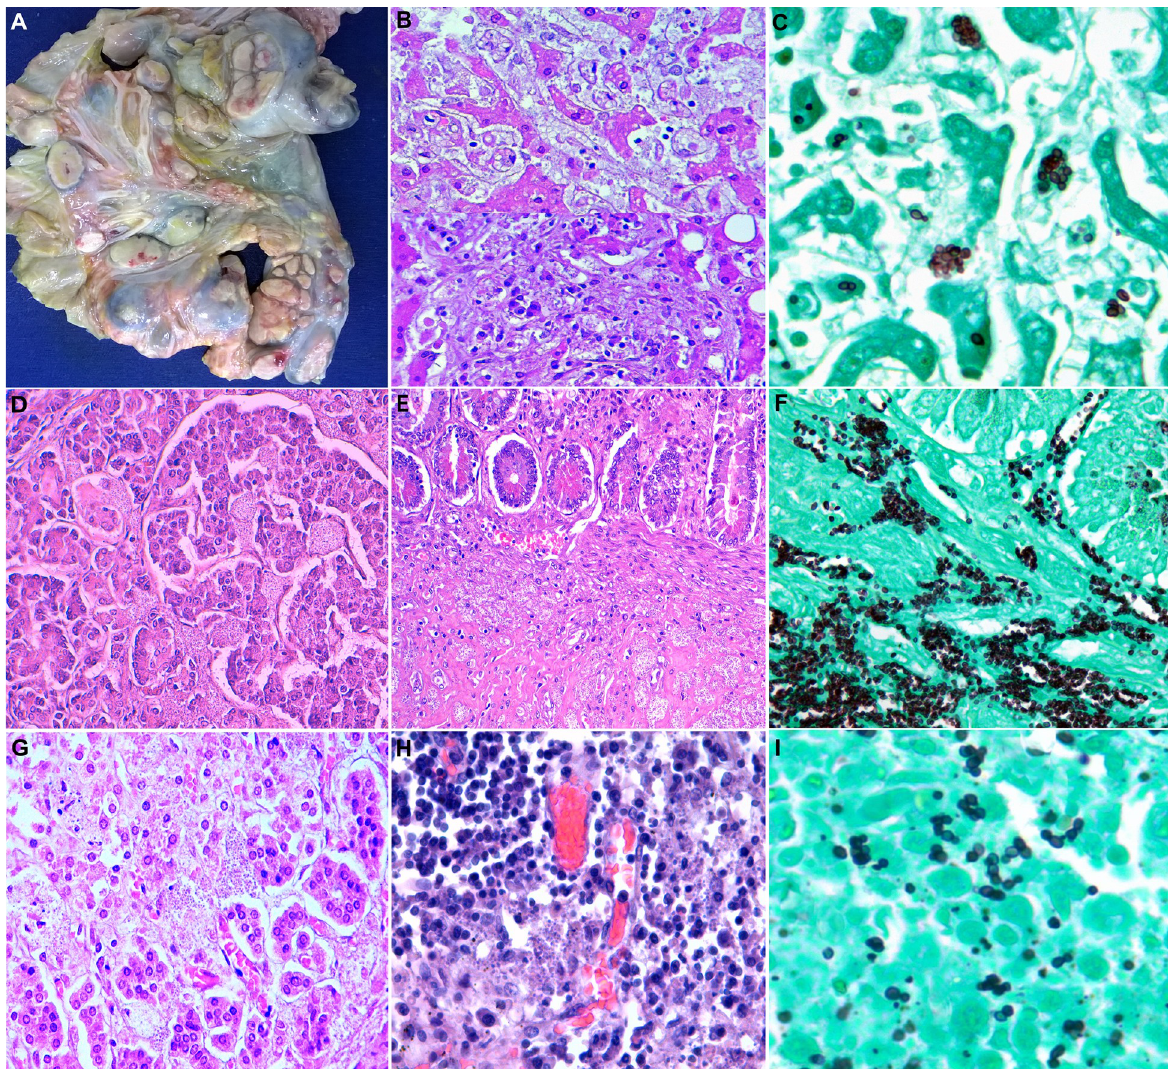
Fig 2. The autopsy findings in extrapulmonary organs in disseminated histoplasmosis. (A) Massive enlargement of mesenteric lymph nodes. No intestinal involvement by Histoplasma was observed in this case. (B) The microscopic liver lesions by Histoplasma : granule-laden macrophages in sinusoids and ill-defined granulomatous lesions (hematoxylin & eosin 400x). (C) Budding oval-shaped, mostly arranged in a grape cluster, Histoplasma yeasts positive for Grocott-Gomori stain (600x). (D) Pancreatic parenchyma showing easily identifiable, abundant fungal spores affecting acini and islet of Langerhans (hematoxylin & eosin 400x). (E) Large bowel wall with extensive submucosal involvement by visible fungal spores (hematoxylin & eosin 400x), highlighted with Grocott-Gomori stain (400x)(F). (G) and (H), Adrenal gland and lymph node, respectively, with the presence of dot-like, bluish structures, consistent with Histoplasma (hematoxylin & eosin 400x). (I) Isolated, paired and clustered budding of H . capsulatum yeasts stained positive with Grocott-Gomori stain